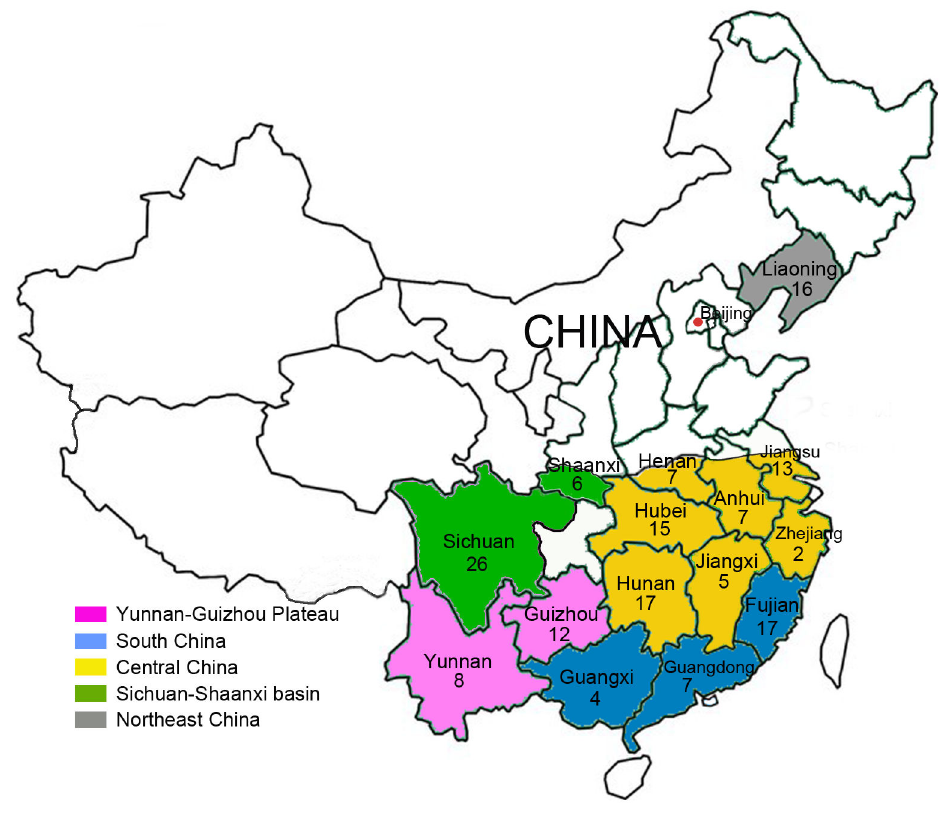
Figure 1. Geographical distributions of U. virens samples in China. A total of 162 U . virens isolates from 15 provinces, covering the five major rice-growing areas of China, were used in this study. Each rice-growing area is marked with a unique color on the